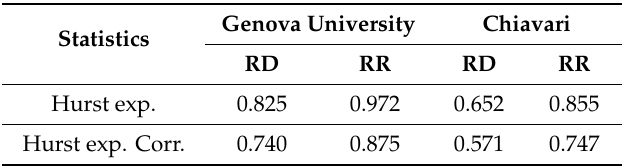
Table 7. The Hurst exponent, both classical formulation and the corrected one, for rainfall rate (RR) and rainy days (RD) series at Genova University (1833–2019) and Chiavari (1877–2019) rain